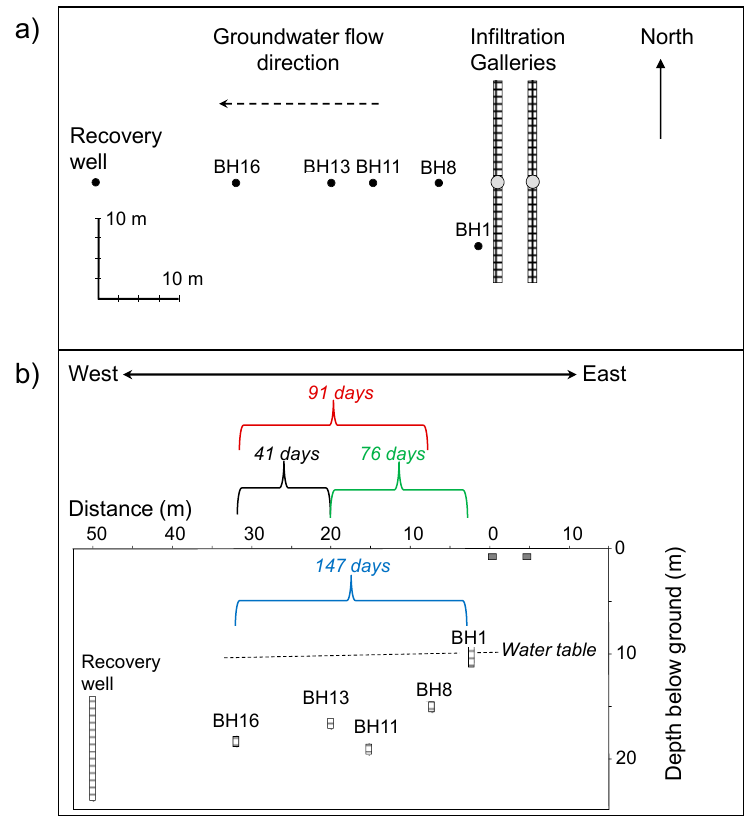
Figure 3. Residence time estimates between several boreholes (BH), using source water temperature as a tracer from a MAR infiltration gallery site (after Bekele et al., 2014 [38]). ( a ) in map view; ( b ) and relative to the maximum height of the water table in cross-section.